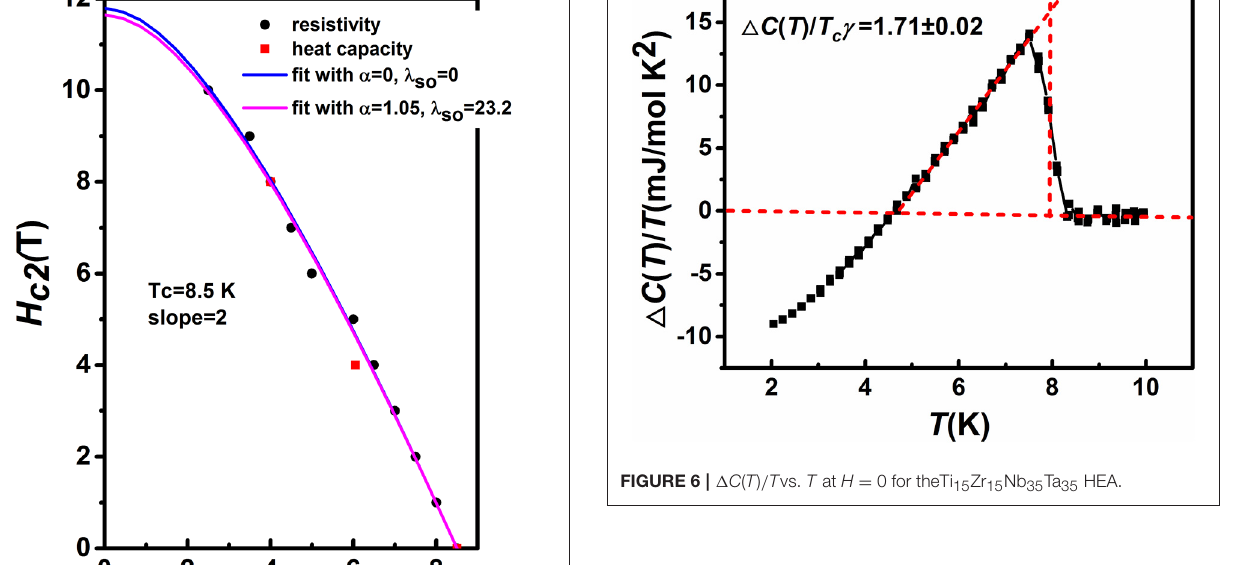
the discontinuous jump of specific heat at the SC transition temperature, i.e., 1 C ( T )